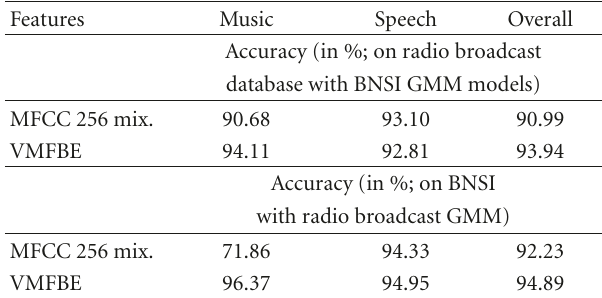
Table 8: Cross-test segmentation performance of VMFBE and MFCC features on BNSI and radio broadcast